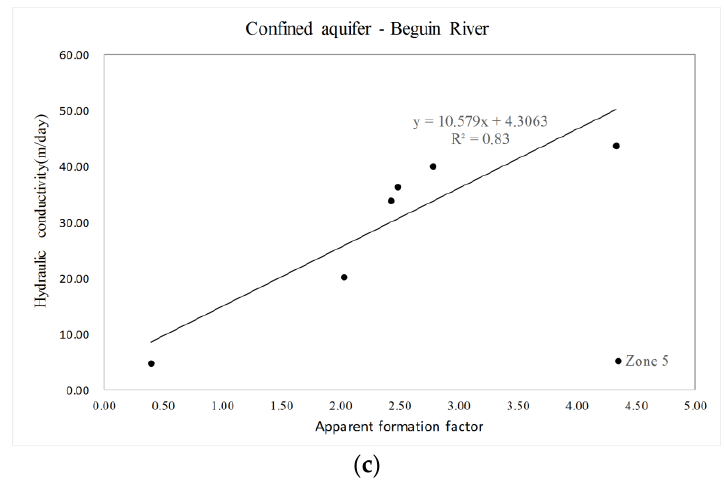
Figure 9. Linear regression results of the data pairs in zone 1, zone 2, zone 4, and zone 5. ( a ) The regression result of the data pairs in zone 2 and zone 4. Shown in ( b ) and ( c ): the regression results of the data pair in zone 1 and zone 5, respectively.